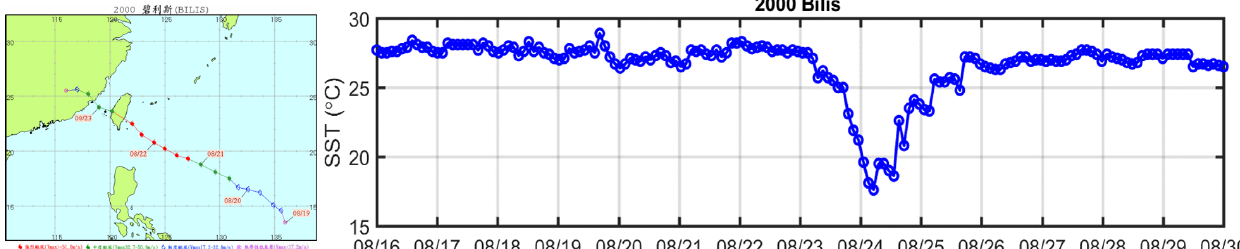
Figure A1. (1) Typhoon Bilis in 2000, max (cid:49) SST = 10.0 ◦ C.